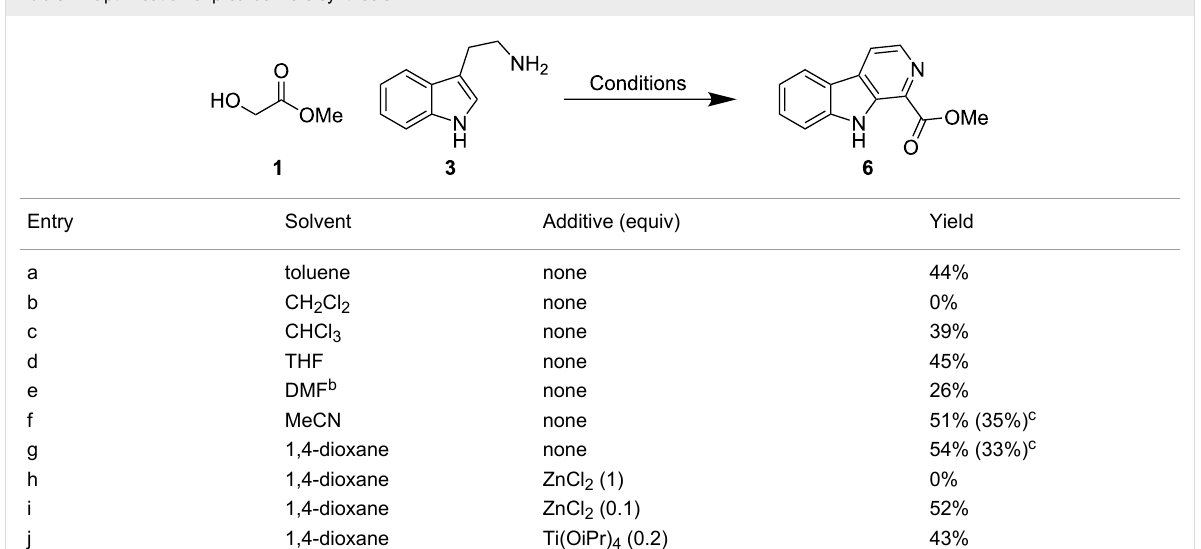
Table 1: Optimisation of β -carboline 6 synthesis. a